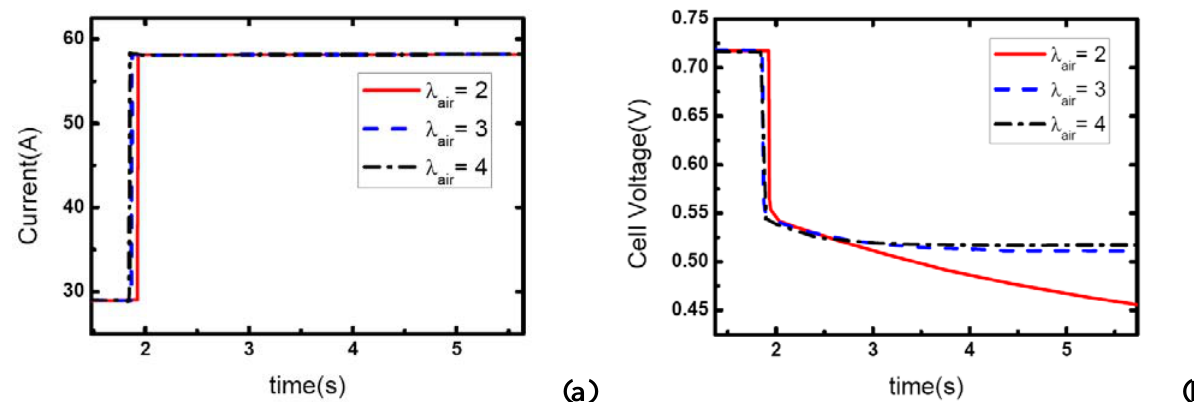
Figure 10. (a) Current change at three different stoichiometric ratios in cathode when the initial current is 28.5 A, (b) corresponding dynamic responses of voltage.